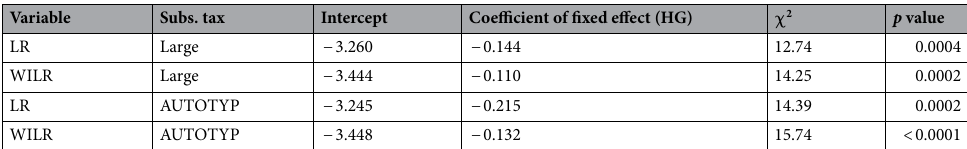
Table 2. Summary of the linear mixed effects models based on logit-transformed LR and WILR values. For the larger subsistence taxonomy, N = 2729 (233 lineages and 24 areas). χ 2 values based on contrasts between fixed and null models. For AUTOTYP data, N = 590 (155 lineages and 24